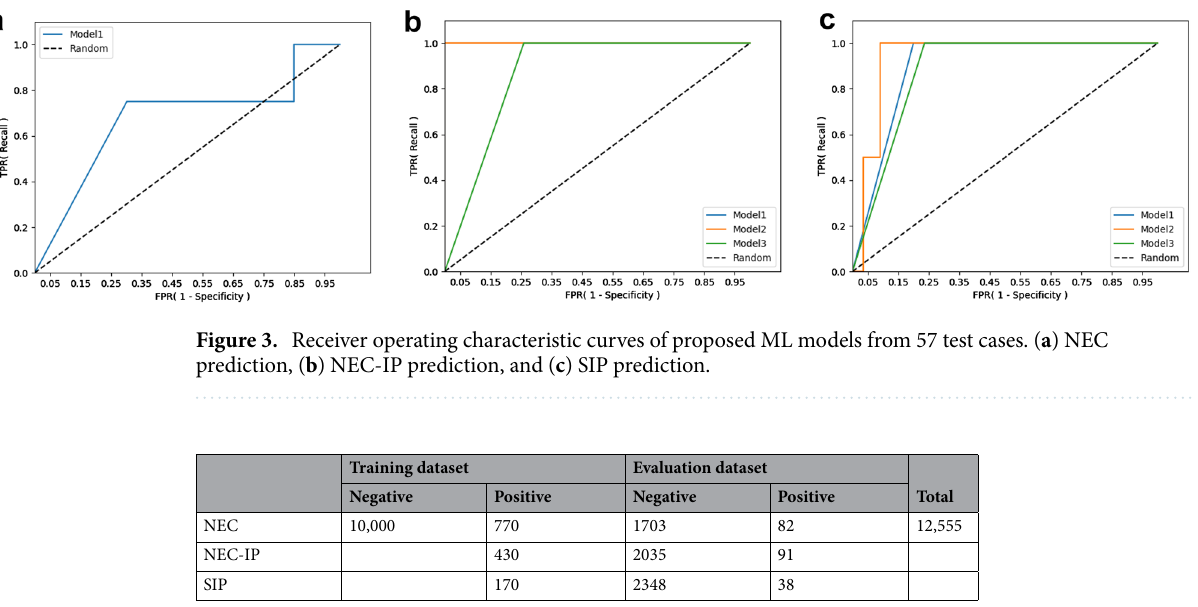
Table 5. Size of training and evaluation datasets. NEC necrotizing enterocolitis, NEC-IP intestinal perforation associated with necrotizing enterocolitis, SIP spontaneous intestinal perforation.